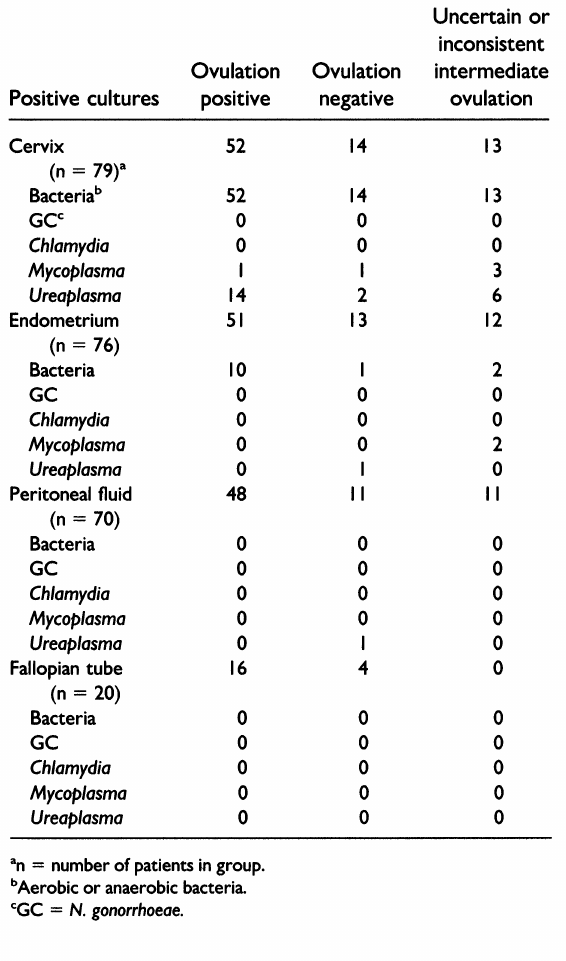
TABLE 3. Culture results in the infertile